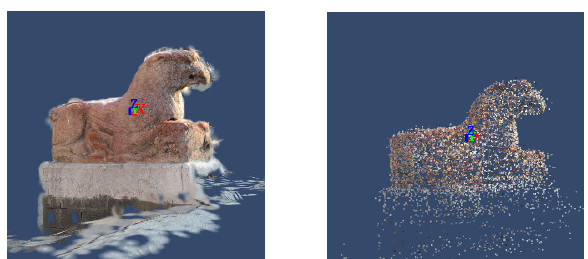
Figure(s) 21-22. Marble Hippogriph statue, Ferrara, Automatic Reconstruction, photographs view mode and points view